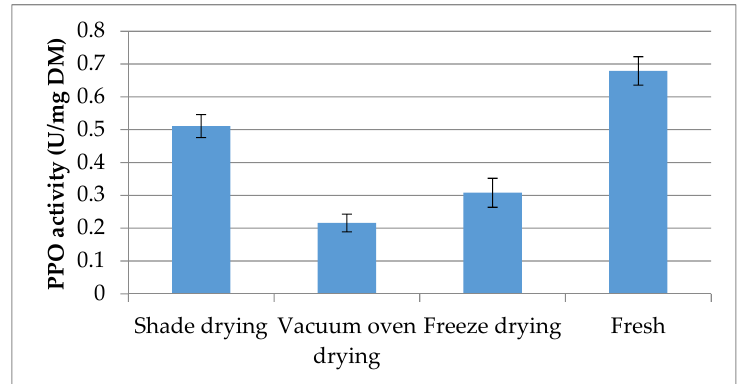
Figure 2. Effect of different drying methods on PPO activity in Z. officinale var. rubrum Theilade. Bars represent standard error of the means.